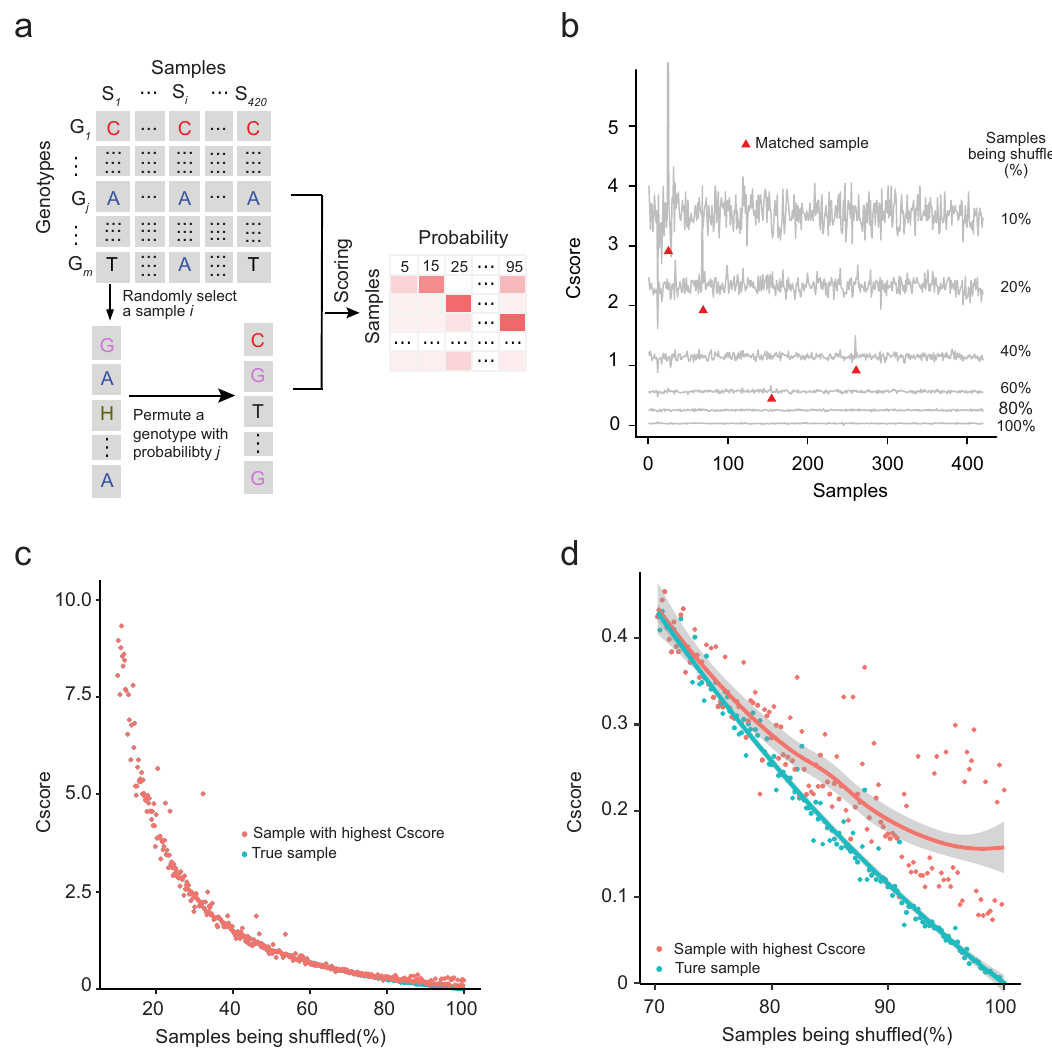
Fig. 2 Parameterization and evaluation of SMAP performance using a simulation study. ( a ) Diagram showing the simulation procedure. See Supplementary Fig. 4 for a more detailed procedure. “ H ” is used to denote heterozygote. ( b ) Curve plot showing Cscore distribution. The X-axis represents 420 samples and the y-axis represents Cscore between a testing sample and each sample in the simulation data. ( c ) Score distribution of the matched sample with the highest Cscore and “ true ” sample along with the percentage of samples being shuf fl ed. The X-axis represents the percentage of samples being shuf fl ed and the Y-axis denotes Cscore. The red dot is the “ true ” sample and the blue is the one with the highest score. ( d ) A zoom-in plot of the score distribution with samples being shuf fl ed from 70% to 100%. Smoothing curves based on linear model separately for each group are shown in red and blue, respectively, with 95% con fi dence intervals in